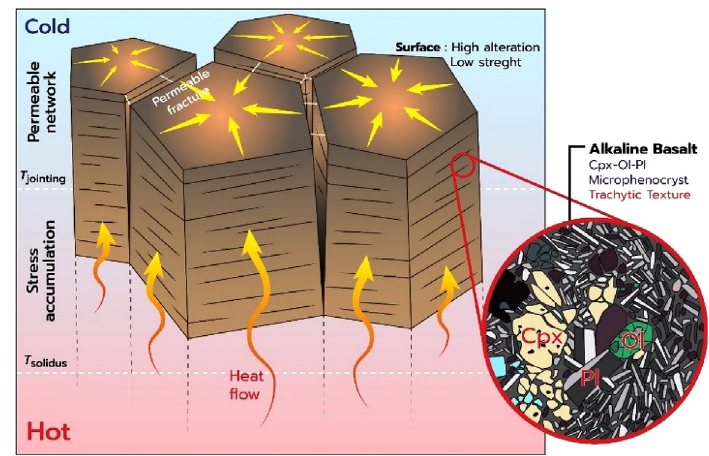
Fig. 10. SWOT analysis for geotourism strategic planning. SWOT: